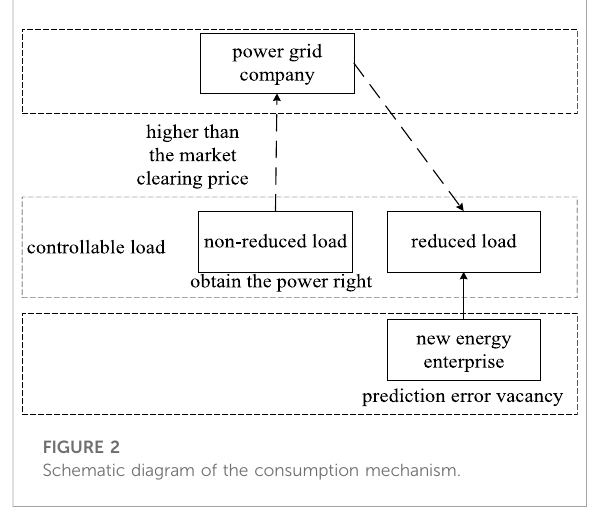
FIGURE 2 Schematic diagram of the consumption mechanism.